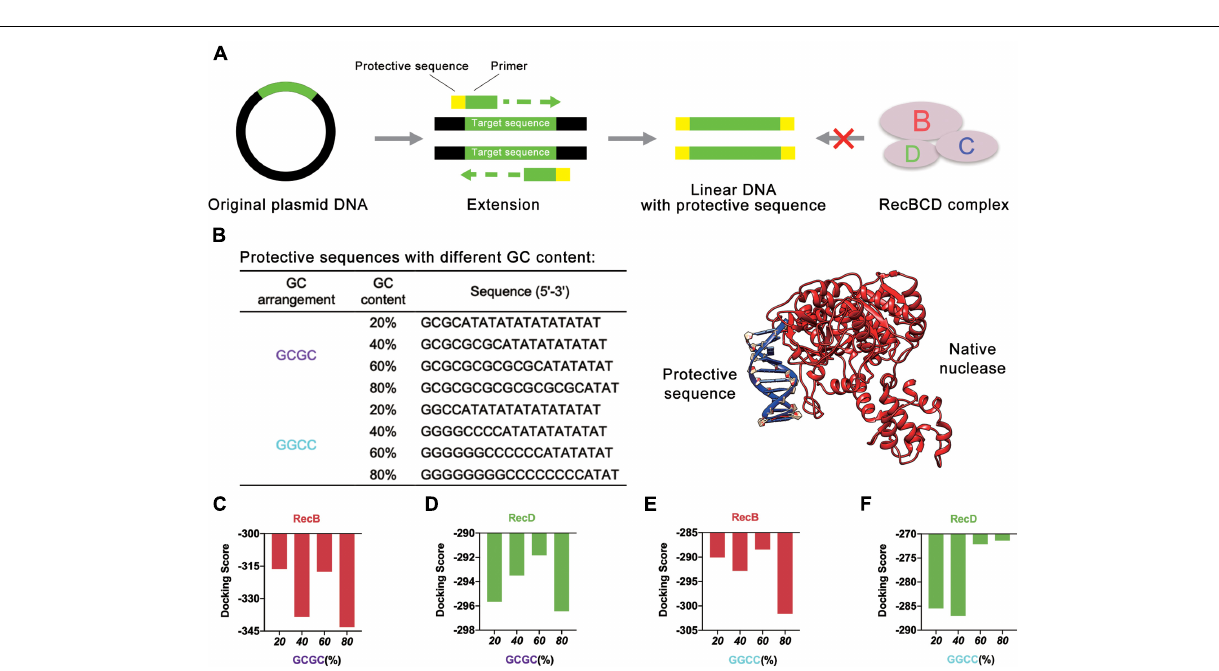
FIGURE 2 | Protective sequences with different GC content. (A) The protective sequences were added to the ends of linear DNA by PCR. The protective sequences could protect linear DNA from the degradation of native nucleases. (B) Protective sequences with different GC arrangement and GC content. GC arrangement included GCGC and GGCC. GC content included 20, 40, 60, and 80%. The length of protective sequences was 20 bp. The diagram on the right side was native nuclease binding with the protective sequence. (C) Simulation results of RecB subunit with different protective sequences. These protective sequences were GCGC arrangement mode and had different GC contents. (D) Simulation results of RecD subunit with different protective sequences. These protective sequences were GCGC arrangement mode and had different GC contents. (E) Simulation results of RecB subunit with different protective sequences. These protective sequences were GGCC arrangement mode and had different GC contents. (F) Simulation results of RecD subunit with different protective sequences. These protective sequences were GGCC arrangement mode and had different GC contents.